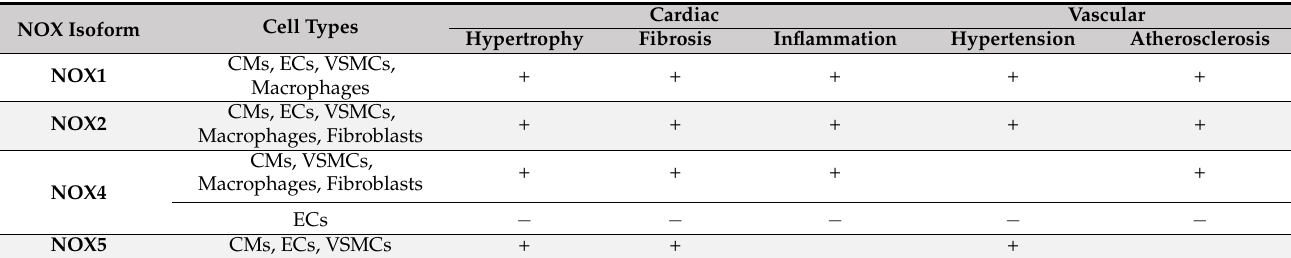
Table 2. Cell type distribution of NOX isoforms and functions in cardiac and vascular pathologies. “+” indicates promotion of the designated cardiovascular disease phenotype, whereas “ − ” indicates repression of the disease phenotype. CMs , cardiomyocytes; ECs , endothelial cells; VSMCs , vascular smooth muscle cells. See Section 2.